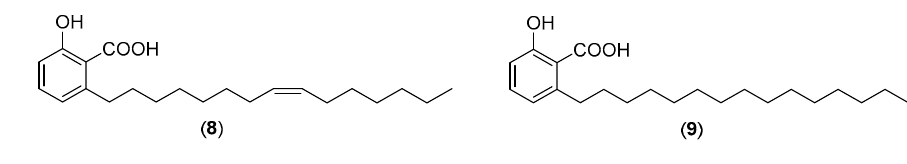
Figure 2. ginkgolic acids ( 8 , 9 ).